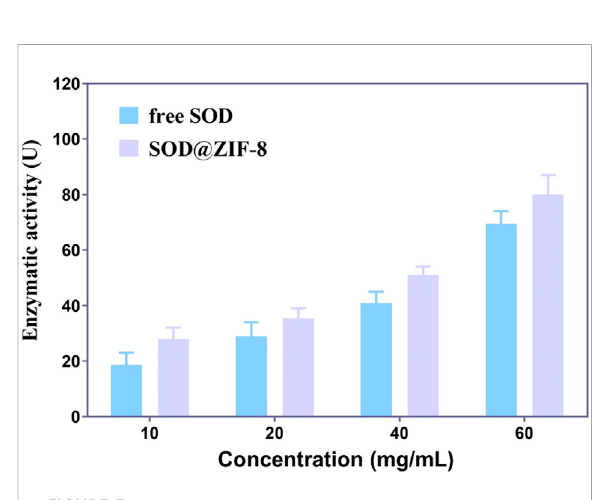
FIGURE 3 The enzymatic activities of free SOD and SOD@ZIF-8 under various